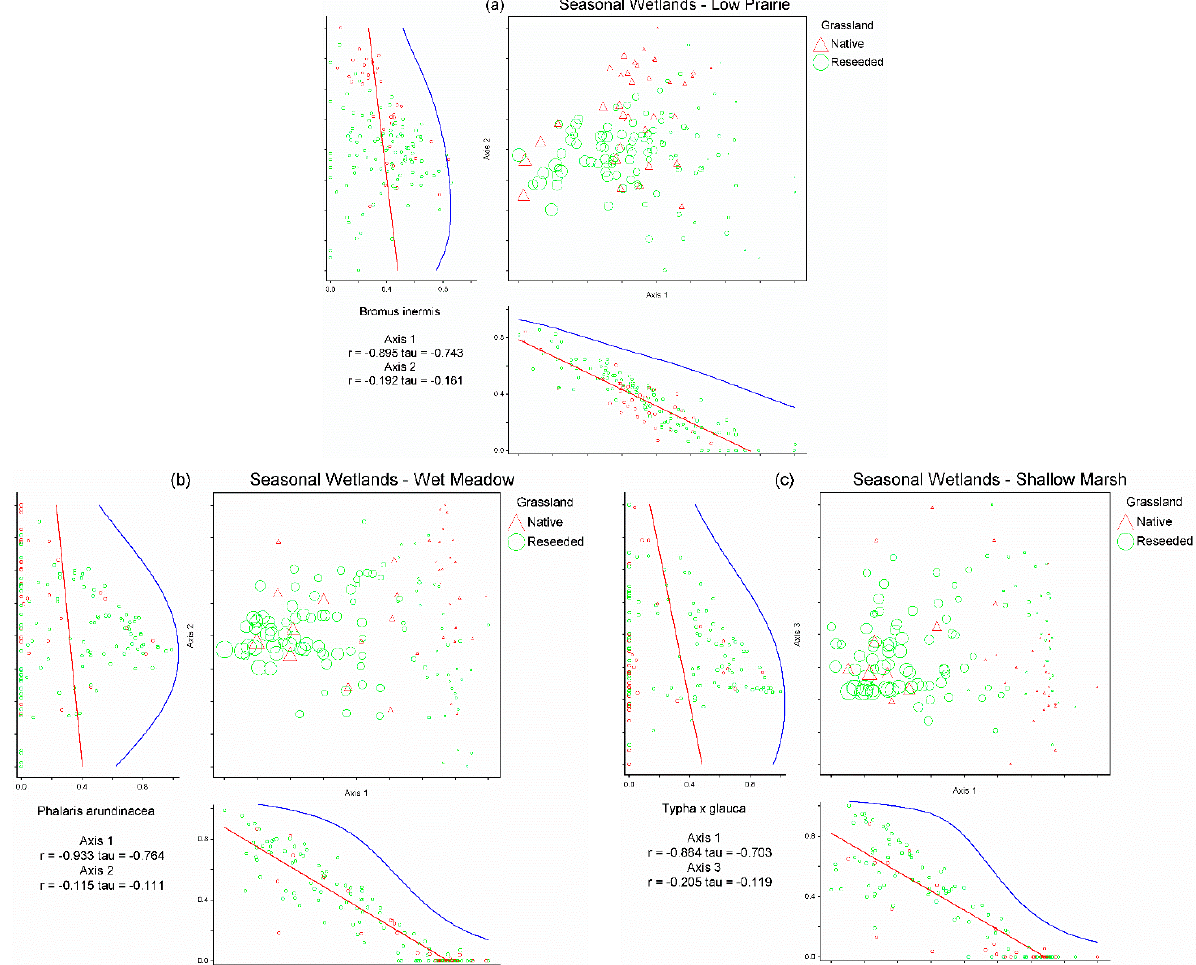
Figure 2. Non-metric multi-dimensional scaling ordinations for the low prairie vegetation zone ( a ), wet meadow vegetation zone ( b ), and shallow marsh vegetation zone ( c ) of 141 seasonal wetlands. Each triangle represents a seasonal wetland located on native grassland and each circle represents a seasonal wetland located on reseeded grassland. The relative size of site symbols (triangles/circles) indicates the relative cover of Bromus inermis in the low prairie zone ( a ), Phalaris arundinacea in the wet meadow zone ( b ), and Typha ×glauca in the shallow marsh zone ( c ). Species’ correlations with each axis are included beneath the horizontal axis and to the left of the vertical axis (i.e., B. inermis in the low prairie vegetation zone ( a ), P. arundinacea in the wet meadow vegetation zone ( b ), T. ×glauca in the shallow marsh zone ( c )).